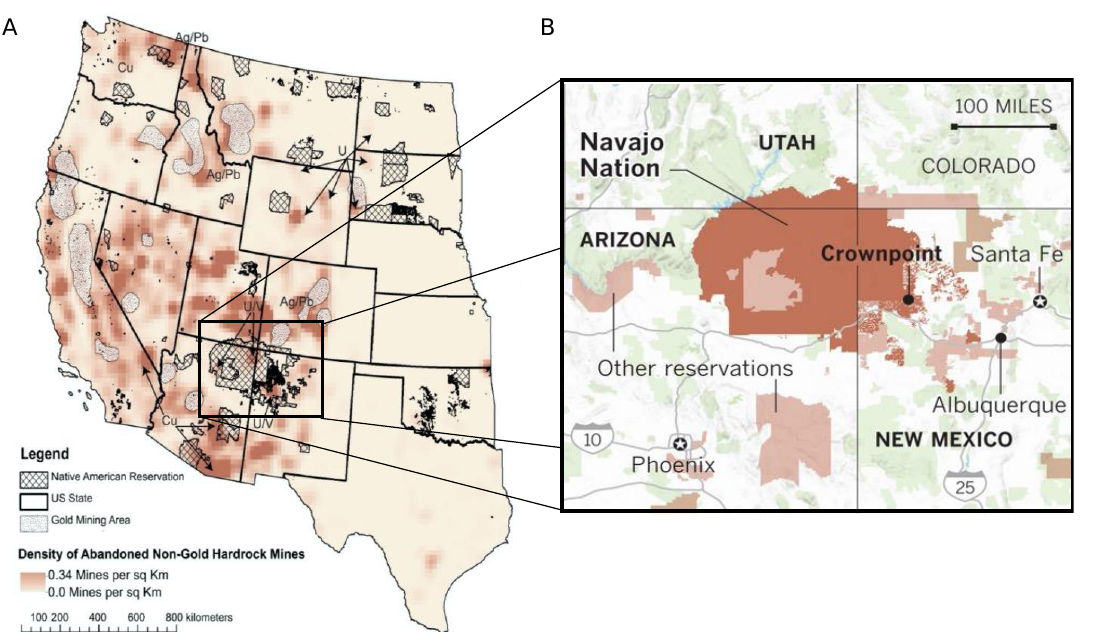
Figure 1. ( A ) Map of the western United States showing the locations of Native American reservations and the density of non-gold hard rock mines (adapted from ref [1]). ( B ) US Census Bureau map of Four Corners Region with Navajo Nation marked in dark brown: its area is approximately 27,000 square miles, roughly equal to that of West Virginia.